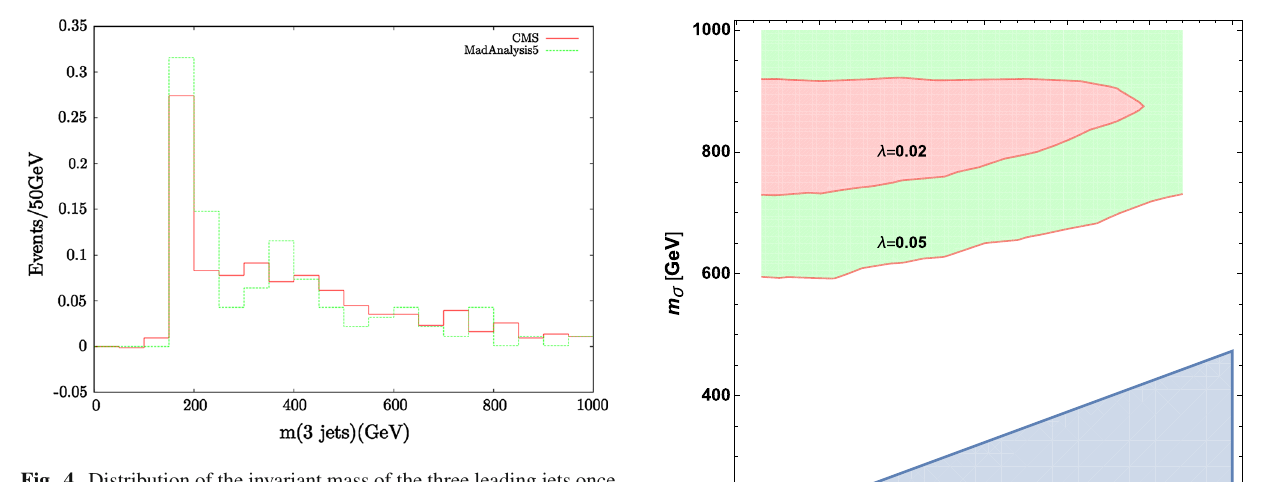
Fig. 4 Distribution of the invariant mass of the three leading jets once all monotop selection steps have been considered, but the one on M 3 j